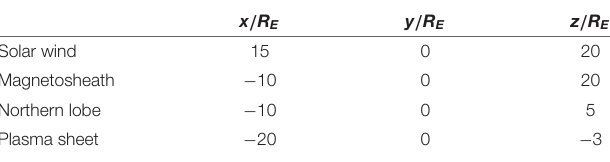
TABLE 1 | Coordinates of the observation points used in the DOI